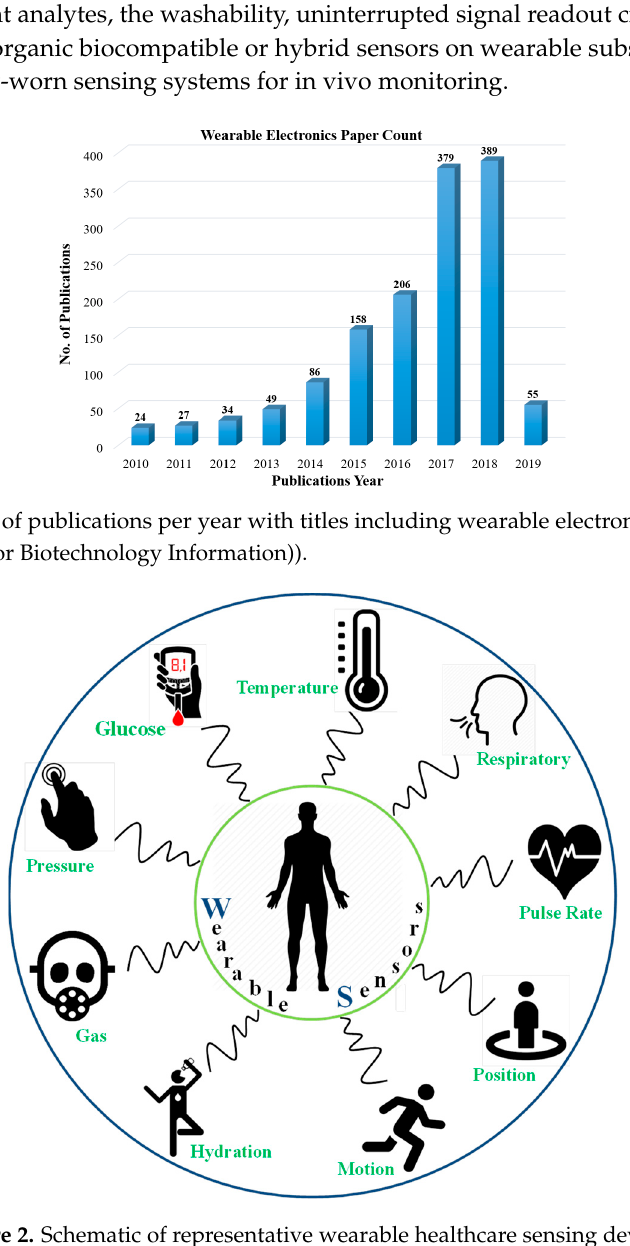
Figure 2. Schematic of representative wearable healthcare sensing devices.